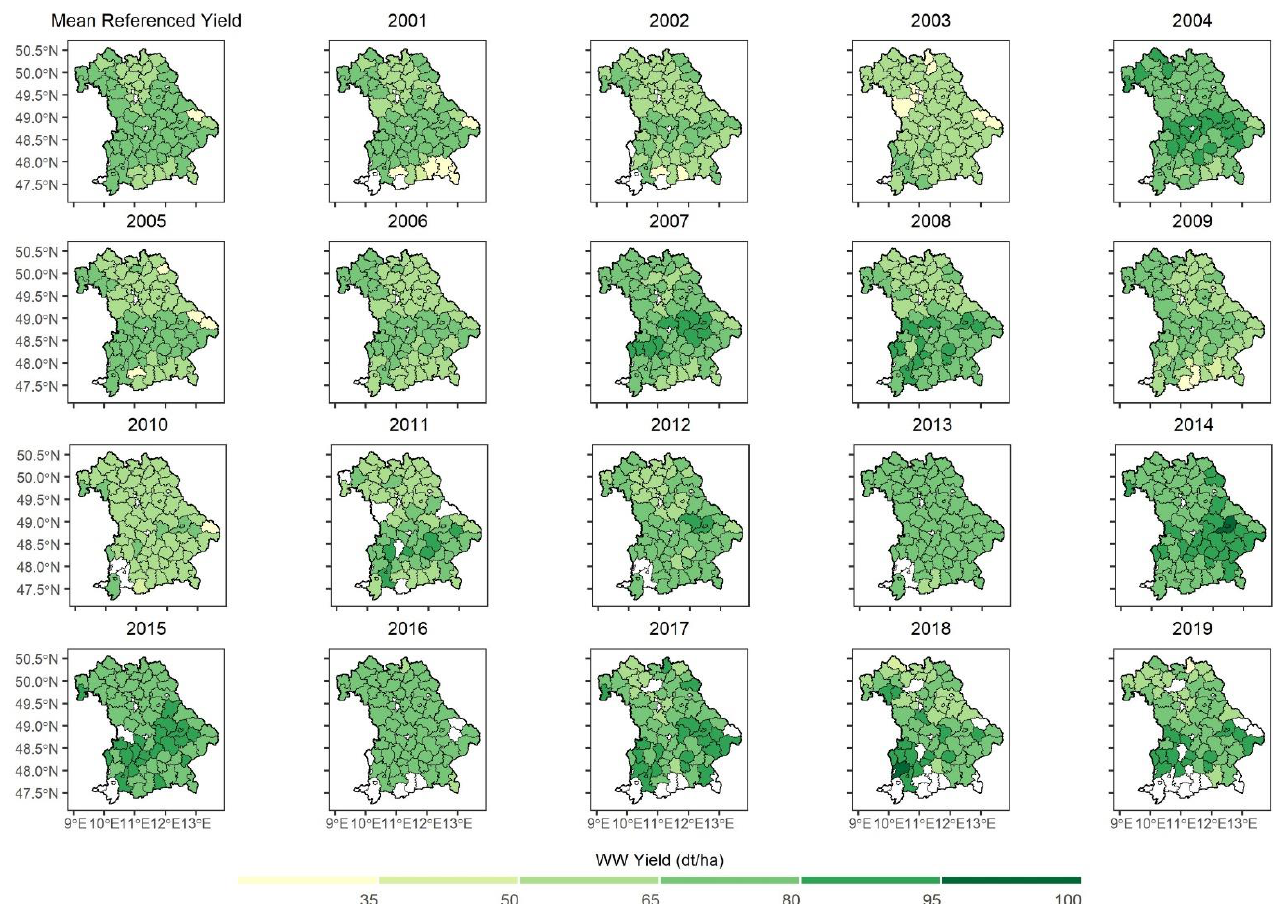
Figure 10. Spatial distribution of mean referenced yield (2001–2019) and the year-wise predicted yield for WW from 2001 to 2019 using the LUE model for the state of Bavaria. The white colour represents no available data. A detailed map of the administrative regions of Bavaria is shown in Figure A1.